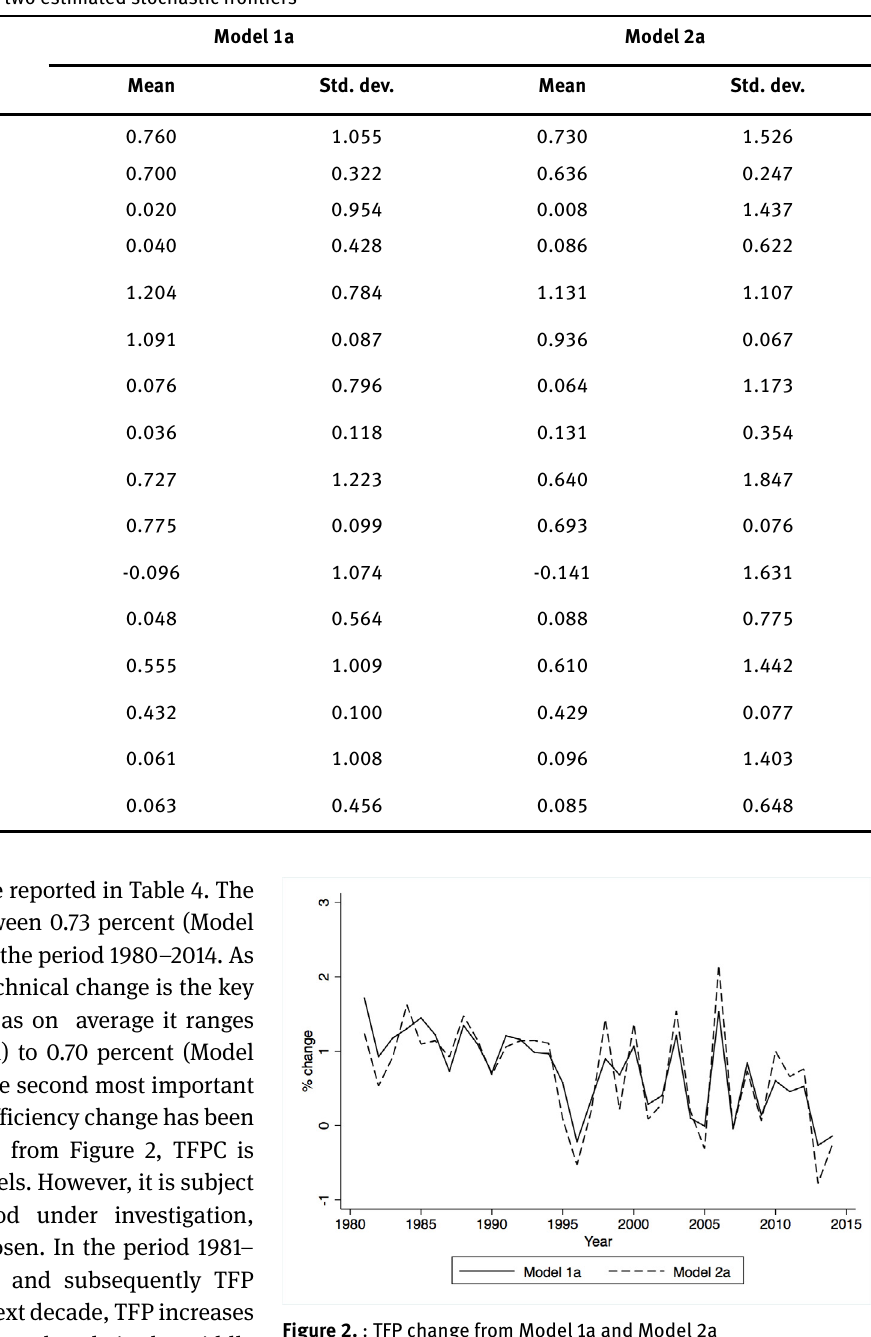
Figure 2. : TFP change from Model 1a and Model